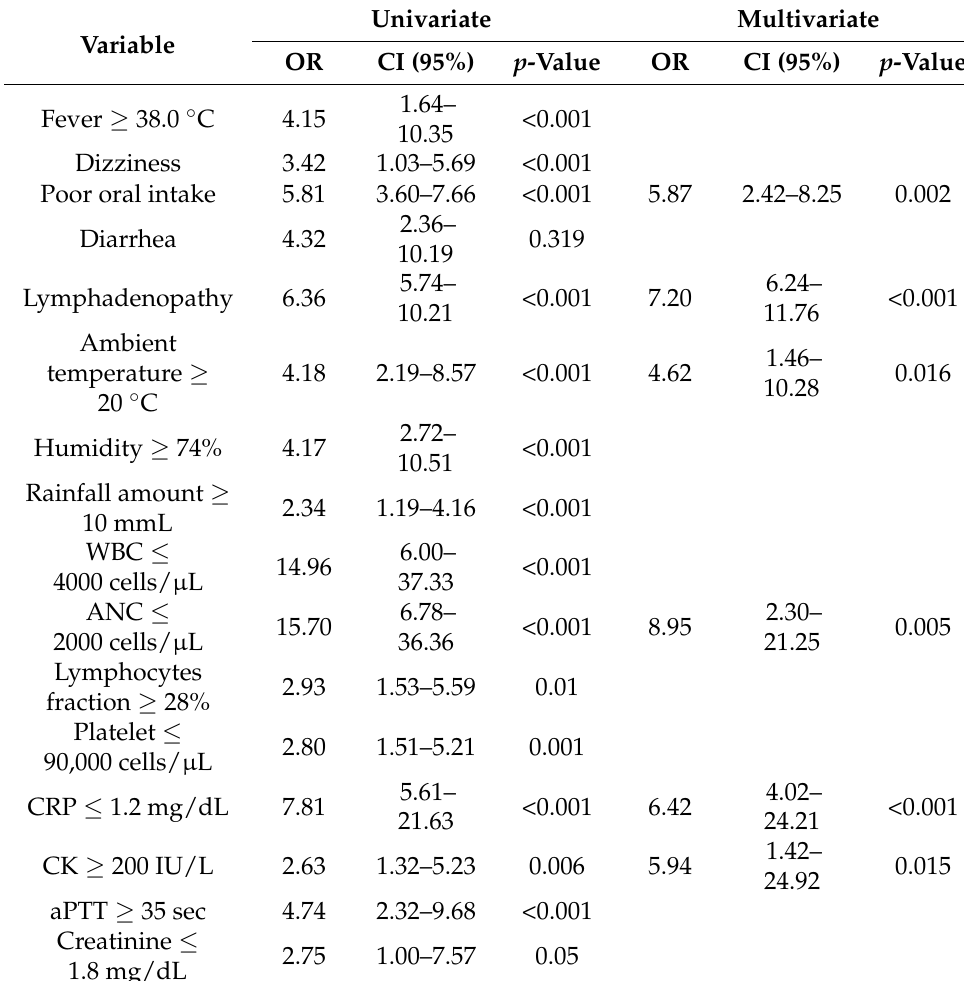
Table 3. Univariate and multivariate logistic regression analyses of factors associated with positive results for severe fever with thrombocytopenia syndrome using